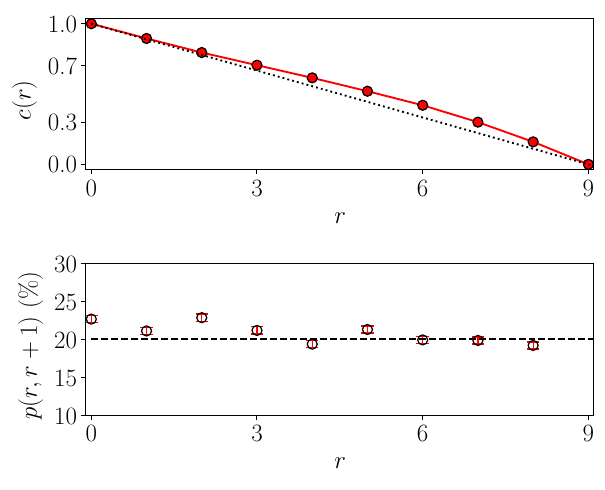
Figure 2 . Behavior of c ( r ) as a function of the replica index r compared to a simple linear behavior (figure above), along with the corresponding acceptances ( and r + 1 (figure below). Data refer to a run with N = 4, β = 11 . 347 and θ L = 0.